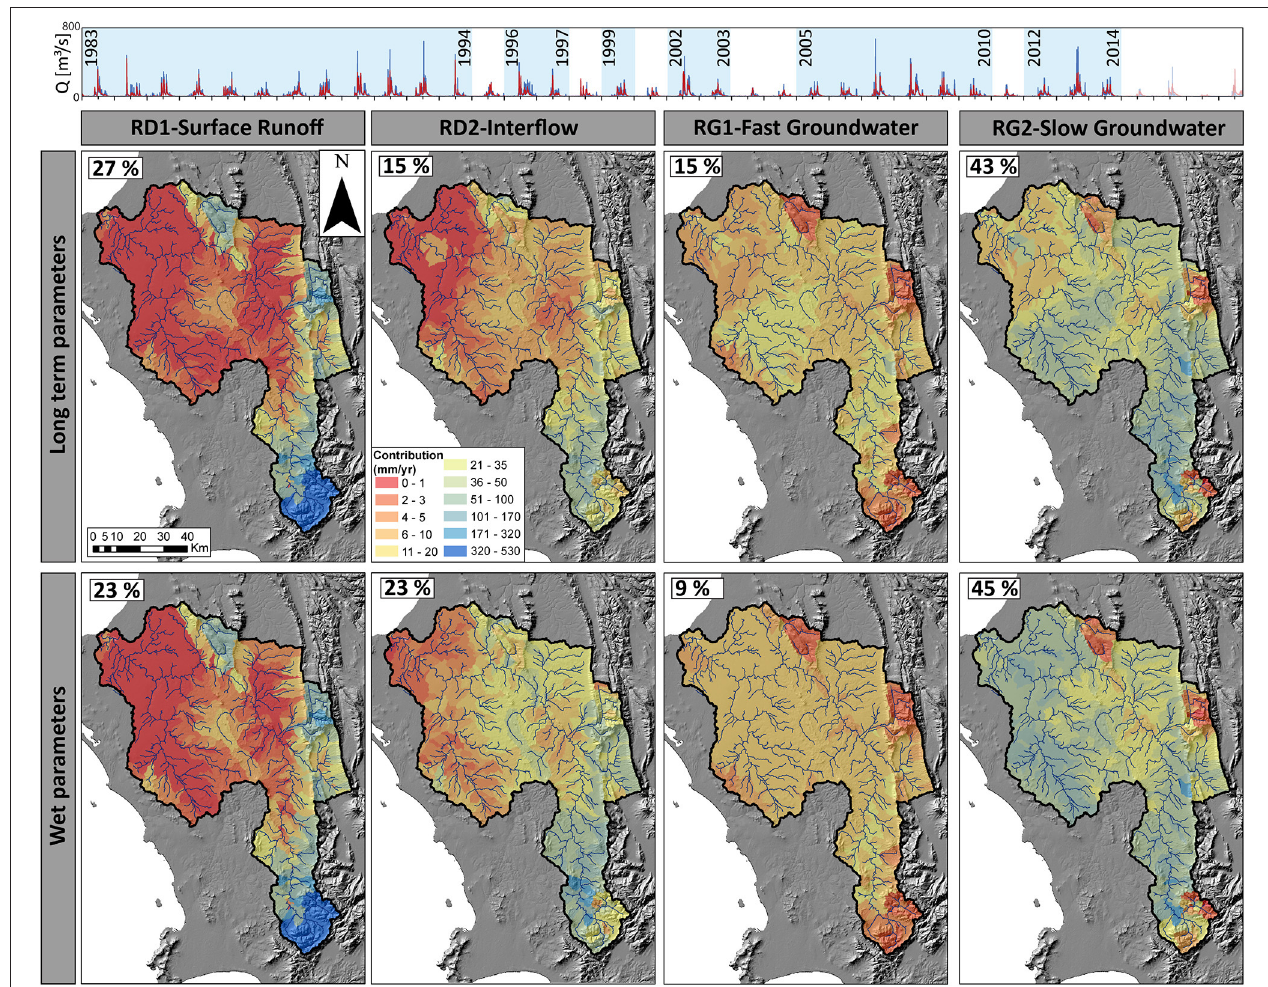
FIGURE 7 | The long-term (1984–2018) time series of the simulated (red line) and observed streamflow (blue line) with the yearly contribution of surface runoff (RD1), interflow (RD2), fast groundwater (RG1) and slow groundwater (RG2) for the identified wet periods (1983–1997, 1999, 2001–2002, and 2005–2010) using the parameters θ long − term and θ wet with the average percentage contribution for each of the flow components. Spatially θ long − term and θ wet are similar, but differ by the contribution of interflow (8%) and fast groundwater